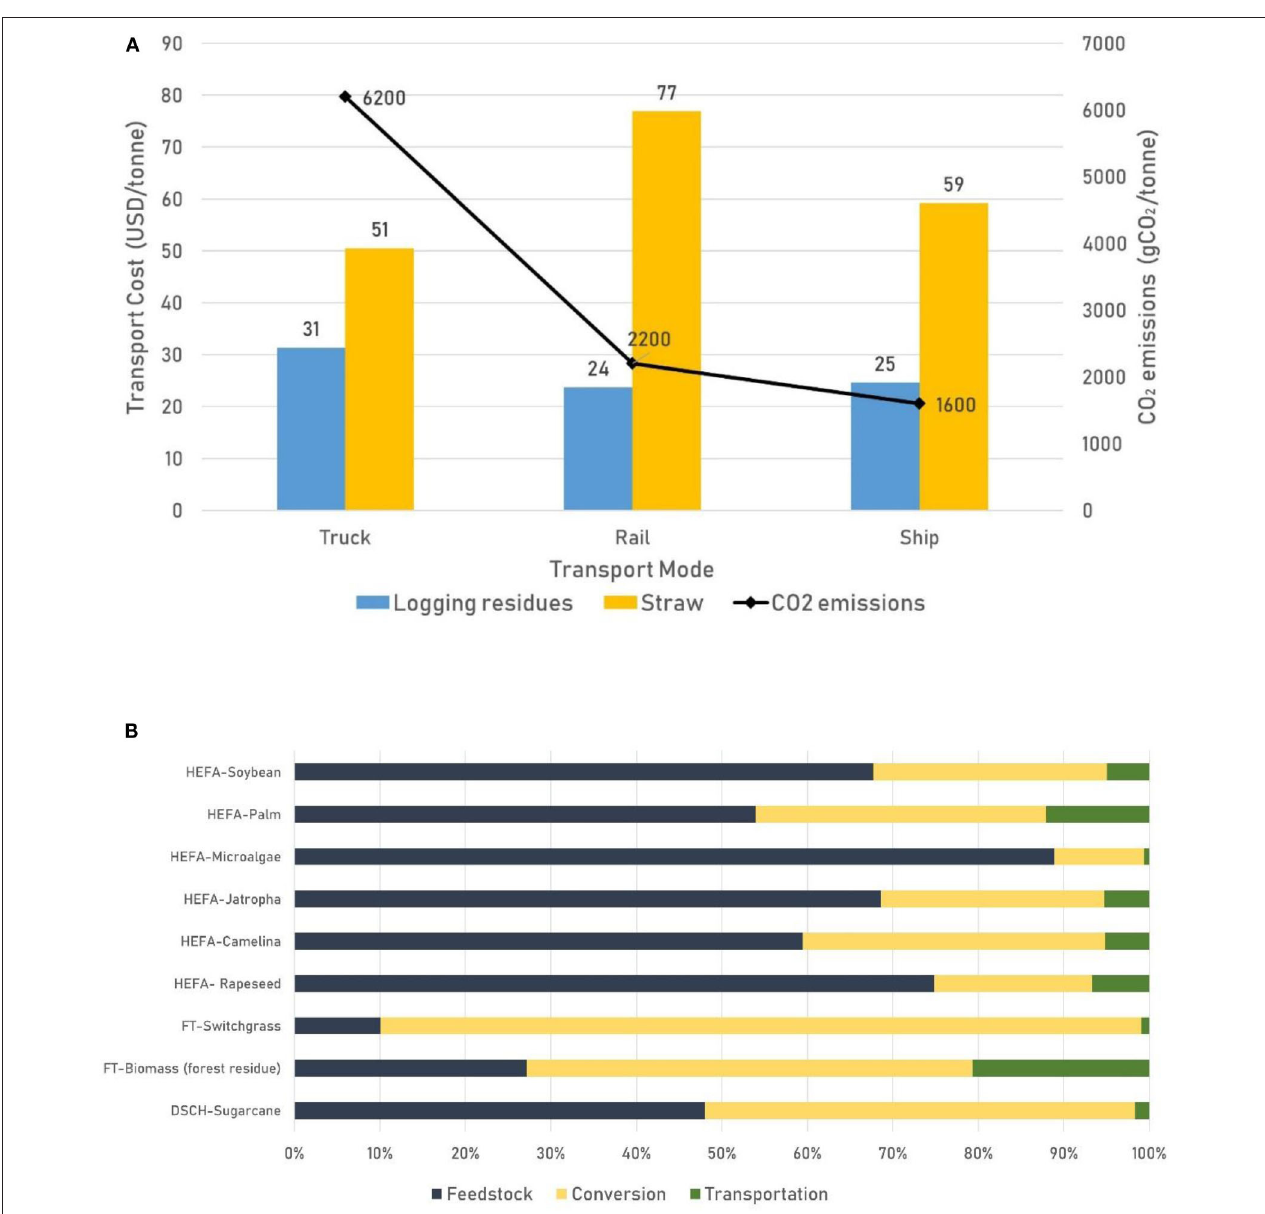
FIGURE 10 | Economic and environmental impacts of transporting BAF feedstocks: (A) Average cost and GHG emissions of transport modes used in delivering feedstocks from farm to processing facilities (Plotted using cost data from Ko et al. (2018) and GHG emissions data from Cefic ECTA (2011) for transport by truck, rail and ship; the relative comparison assumed a transport distance of 100km); and (B) Breakdown of GHG emissions by phases for HEFA, FT and DSCH for a variety of feedstocks (Plotted using data from Capaz and Seabra